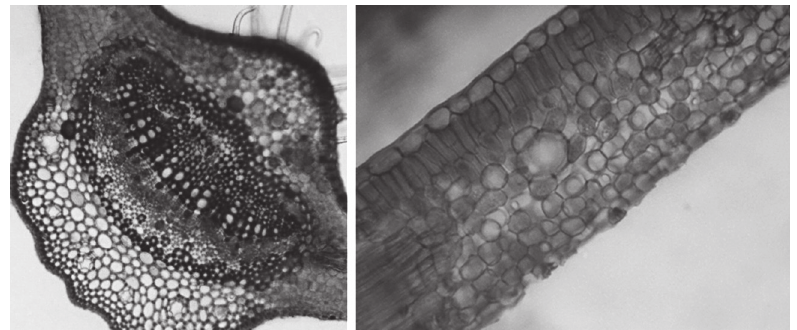
Figure 1 - Tranverse section of the midvein region from the leaf of C. sylvestris var. lingua (a) and tranverse section of the region between the midvein and the margin from the leaf of C. sylvestris var. sylvestris (b)